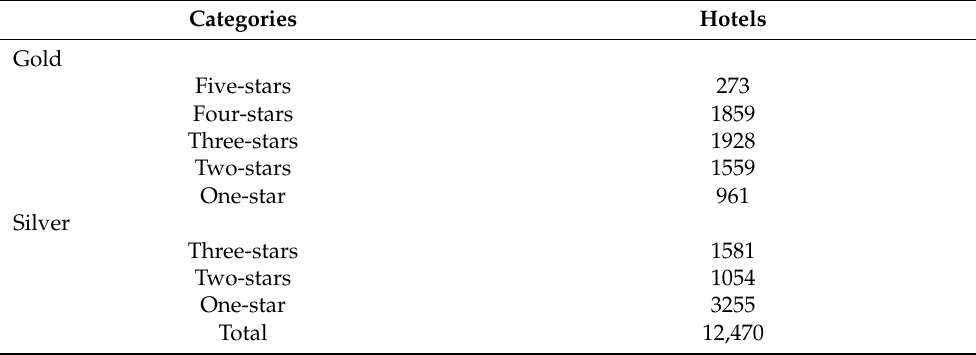
Table 2. Hotel distributions in Spain.